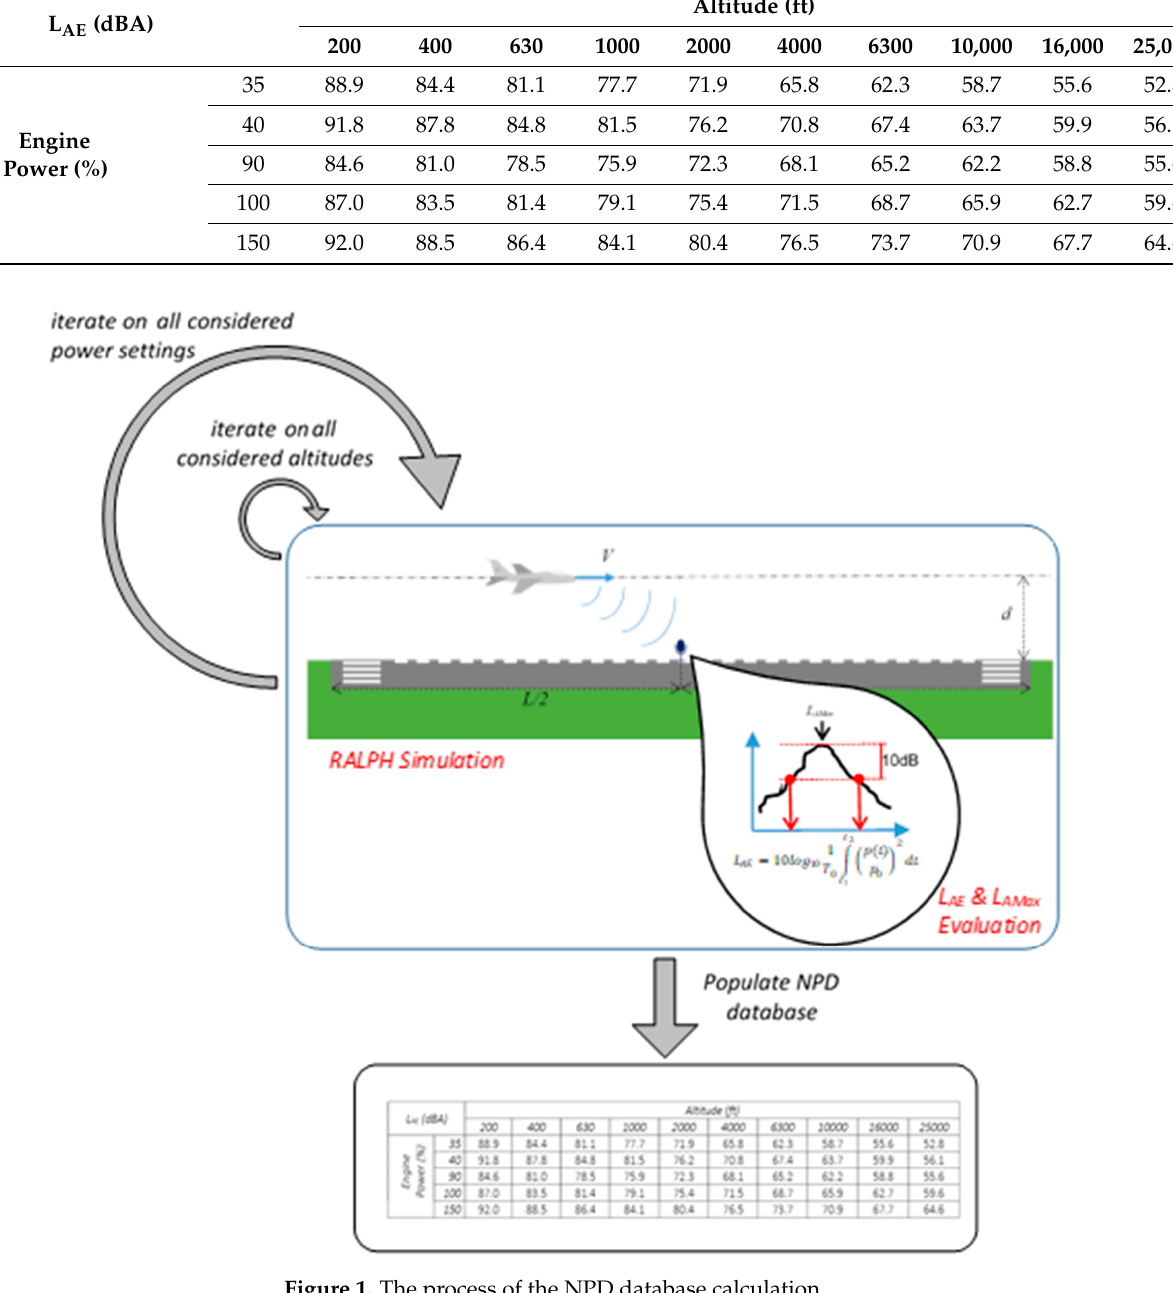
Figure 1. The process of the NPD database calculation.